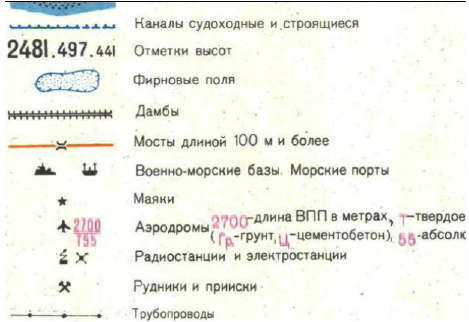
Fig. 10. Symbols of a Soviet aeronautical chart at the scale of 1:500,000, published for the Western Theatre of War